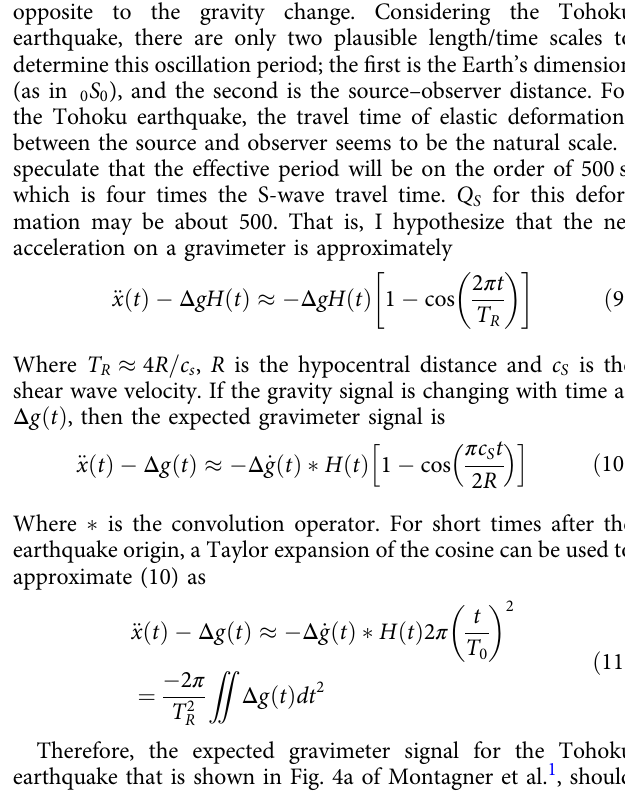
This means that the gravimeter response is very sluggish with time and it is poorly suited to rapidly detect earthquakes as is required for seismic early warning. Examination of Fig. 4b from Montagner et al. 1 shows that their predicted gravitational signal signi fi cantly overpredicts the accelerations recorded by the gravimeter. Perhaps modi fi cation of their predicted acceleration with the convolution of (11) will produce better agreement with the observation. Data sharing is not applicable to this article as no data sets were generated or analyzed during the current study.